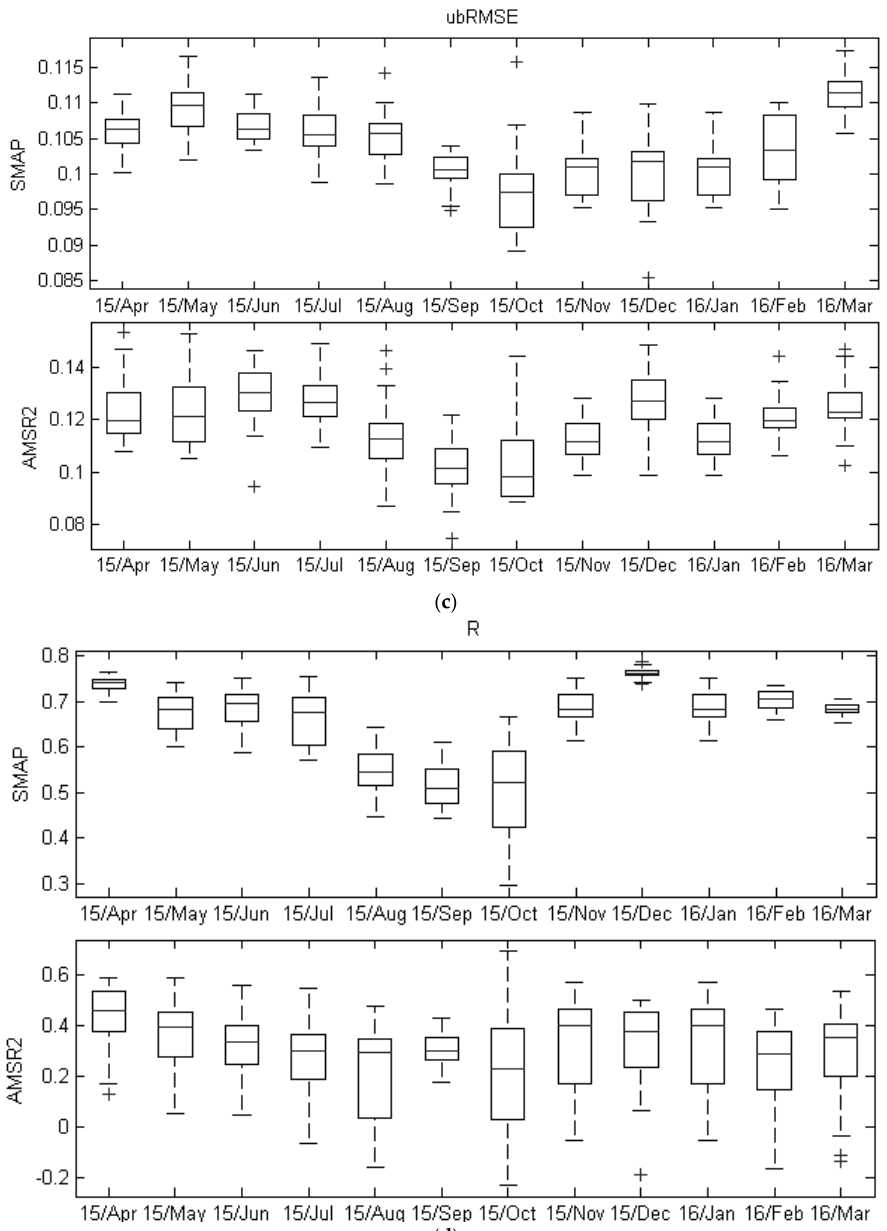
Figure 3. ( a – d ) Temporal evolution of four statistics results for SMAP L4 SM and AMSR2 L3 SM daily data (mean difference (MD), the root mean squared difference (RMSD), the unbiased root mean square error (RMSE) and correlation coefficient (R)). Presented are the median, the 1st quantile Q1 and 3rd quantile Q 3 (as indicated by the box), and the Q1 − 1.5 (Q3 − Q1) and Q3 + 1.5 (Q3 − Q1) values (whiskers).